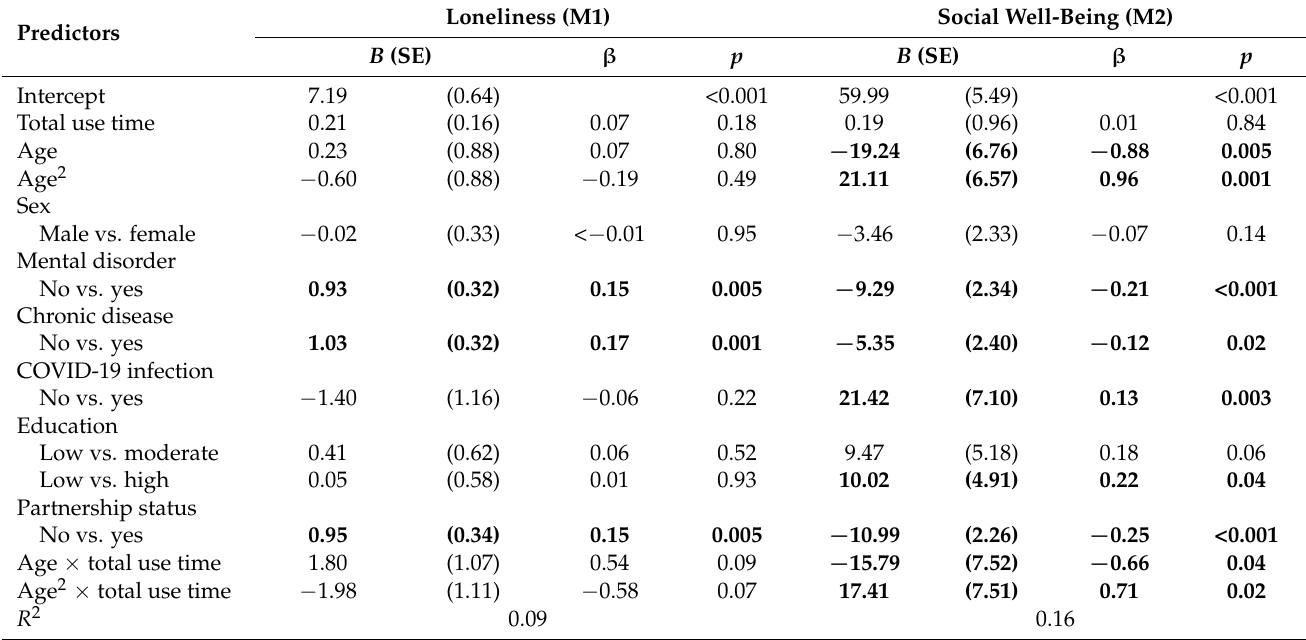
Table 3. Results from multiple regression analyses predicting self-reported loneliness and social well-being by smartphone communication app total use time (average of past seven days) of 359 German adults.